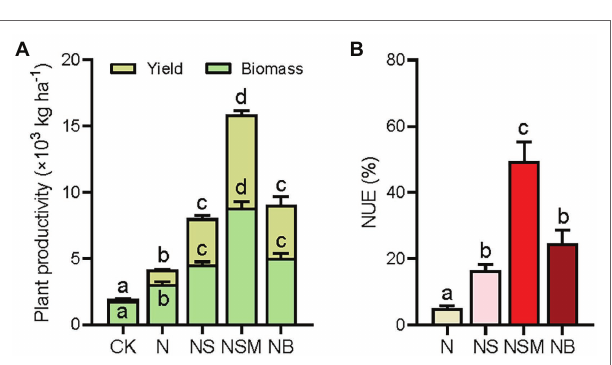
FIGURE 2 | Plant productivity (grain yield and straw biomass, A ) and nitrogen use efficiency (NUE, B ) under the five fertilization treatments. Different lowercase letters indicate significant differences based on Tukey’s HSD test ( p < 0.05). CK, no fertilizer; N, NPK fertilizer; NS, NPK fertilizer and straw; NSM, NPK fertilizer and straw combined with pig manure; NB, NPK fertilizer and straw